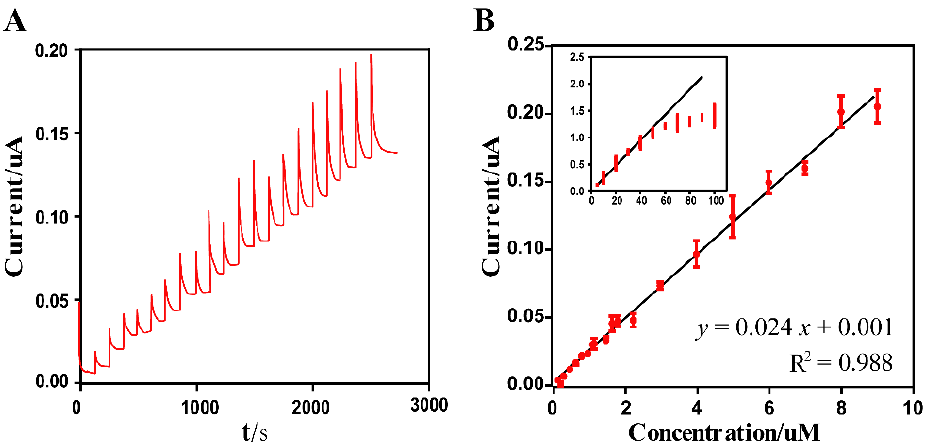
Figure 5. ( A ) Amperometric response curve of the modified electrode at 0.5 V upon successive injection of varying glutamate concentrations in a stirred phosphate buffer saline (PBS) buffer. ( B ) The calibration linear relationship between the oxidation peak currents and the glutamate concentrations (mean ± SD, n = 3).